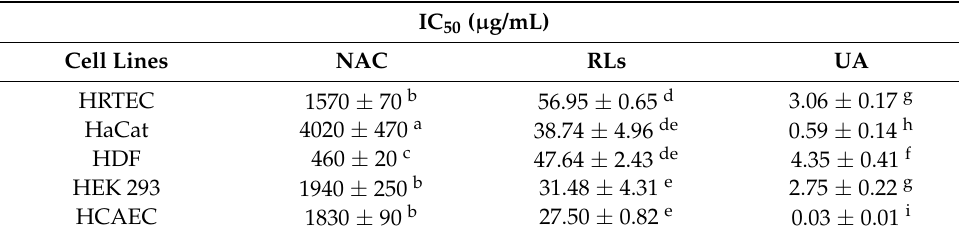
Table 5. Cytotoxicity of natural substances expressed as a concentration that halves the viability of human cells (IC 50 ). The data are presented as an average of 3 repetitions with SEM. The significance of the results was verified by ANOVA (Duncan’s post hoc test, p <